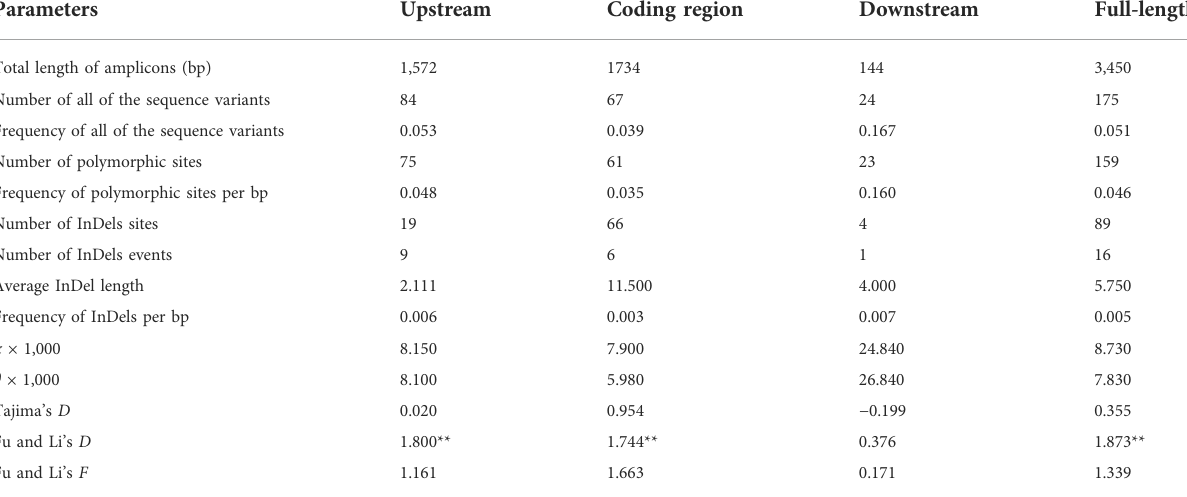
TABLE 1 Summary of parameters for the analysis of nucleotide polymorphisms of ZmFWL7 in inbred lines. Parameters